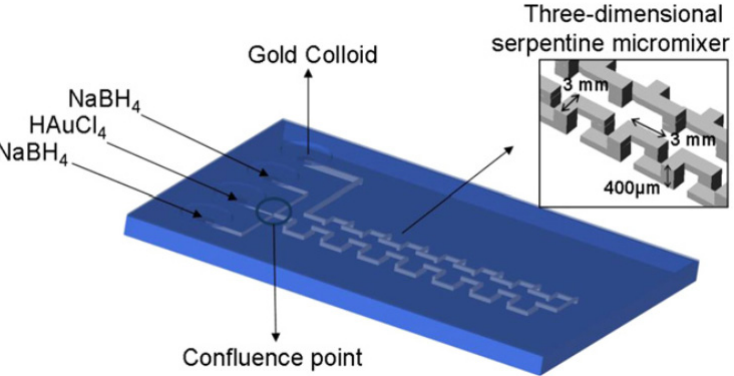
Figure 3. Microfluidic low-temperature co-fired ceramics (LTCC) platform design for the synthesis of gold nanoparticles consisting of the concept of hydraulic focusing and a three-dimensional serpentine micromixer for the reagent mixture